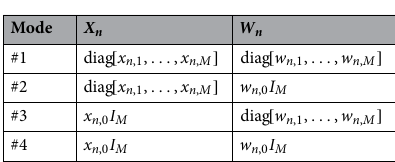
Table 2. Input and weight matrices of the n th